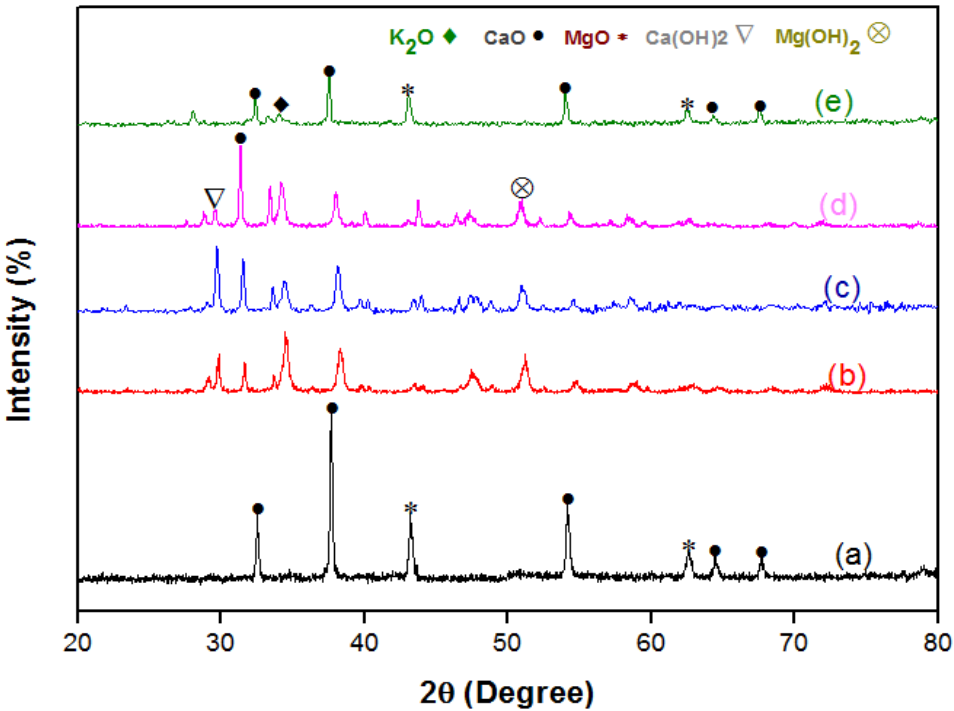
Figure 3. XRD pattern of ( a ) Dolomite ( b ) 5 wt% K/D ( c ) 10 wt% K/D ( d ) 15 wt% K/D ( e ) 20 wt% K/D.